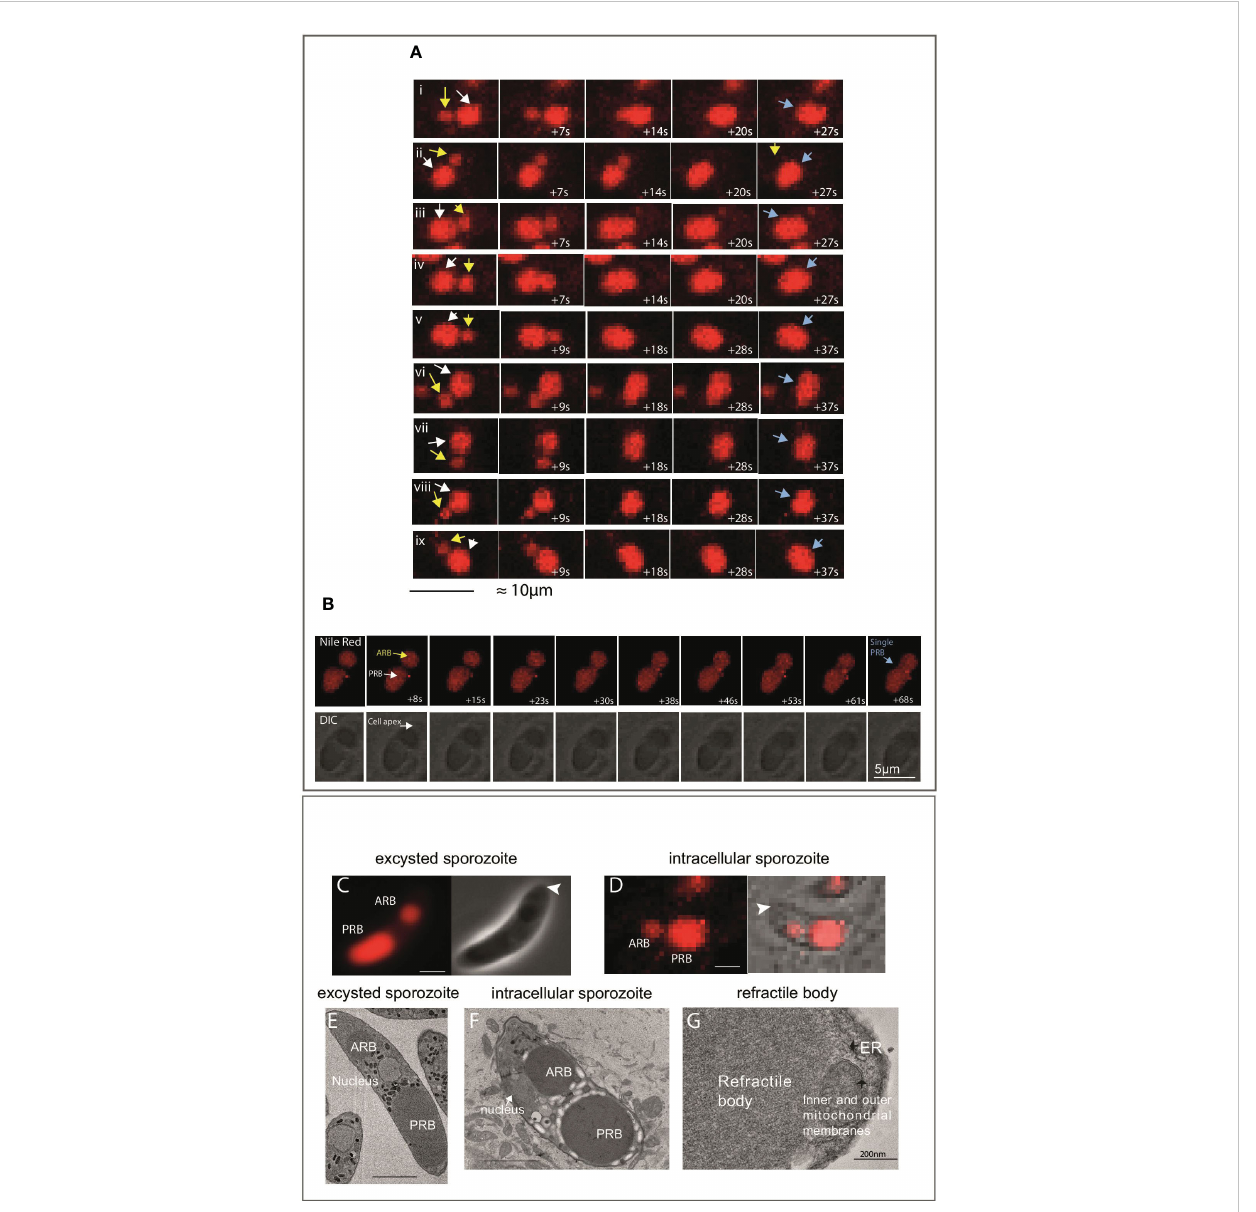
FIGURE 2 Live imaging of sporozoite refractile body merger. (A) Example of time-lapse events of RBant. loss seen in samples imaged between 2-4 hpi. The observed mechanism of RBant. loss was fusion/merger with the RBpost. The fi rst time point shows a smaller RBant. (yellow arrow) positioned close to the large RBpost. (white arrow). In under 40 seconds, the RBant. has completely fused with the RBpost., leaving the sporozoite with a single RB (blue arrow) in the last panel (40x magni fi cation). Scale bar 10 m m. (B) Top panel: fl uorescent microscopy data of a single event of RB merger captured at 63x magni fi cation. Bottom panel: DIC of the same events. Nile Red staining (red) localises to the RBant. and RBpost. Scale bar 5 m m. (C) : Phase contrast and fl uorescence microscopy of a freshly-puri fi ed extracellular sporozoite stained with Nile Red, where there is an ~2 m m gap separating the RBant. with the RBpost. (arrowhead indicates cell apex). (D) : DIC and fl uorescence microscopy of an intracellular sporozoite stained with Nile Red, where there is less than a ~1 m m gap separating the RBant. with the RBpost. (arrowhead indicates cell apex). (E) : SBF-SEM slice of a freshly-puri fi ed extracellular sporozoite to illustrate the positioning and gap between the RBant. and RBpost.; (F) : SBF-SEM slice of a intracellular sporozoite at 3 hpi. The RBant. is located alongside the nucleus and closer to the RBpost. This is not seen in freshly-puri fi ed extracellular sporozoite samples. (G) TEM showing an ampli fi ed region of a RB, no limiting membrane is